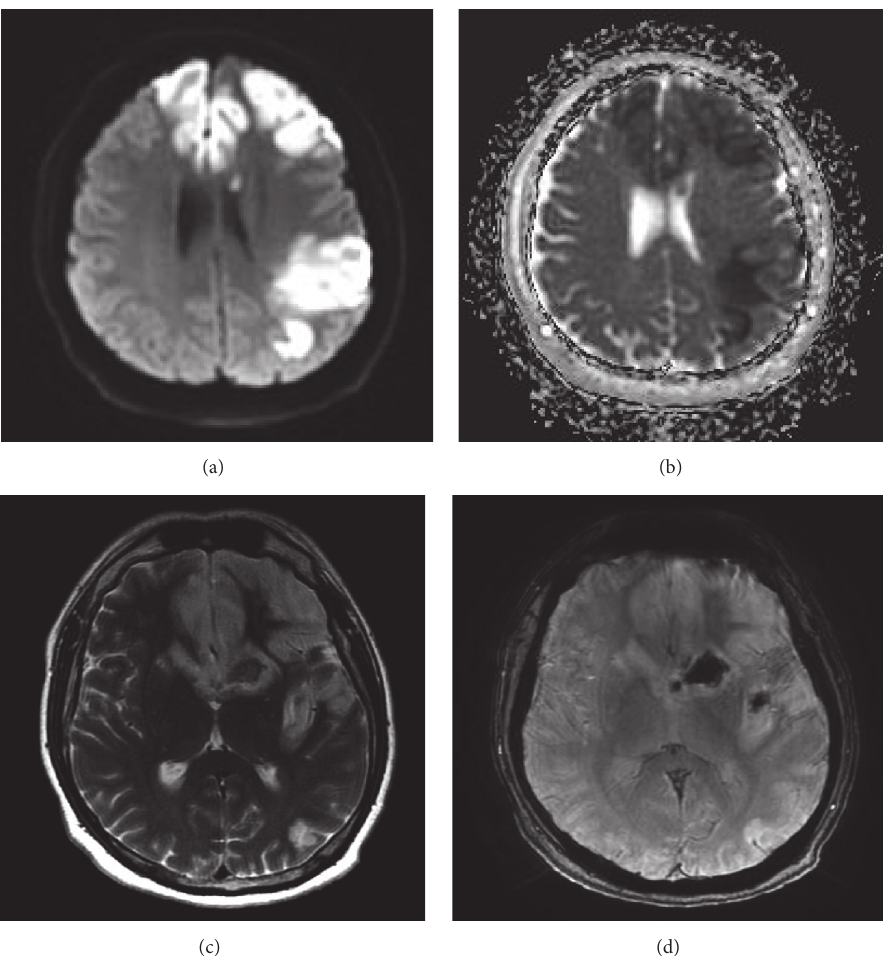
Figure 1: Selected images of MRI of brain. ((a) and (b)) (DWI/ADC) image showing restriction diffusion in bilateral medial frontal lobes and watershed areas in frontal and temporal lobes. (c) T2-weighted image showing hyperintensities in basal ganglia (recurrent artery of Heubner). (d) SWI sequence showing hemorrhagic changes in left basal ganglia and